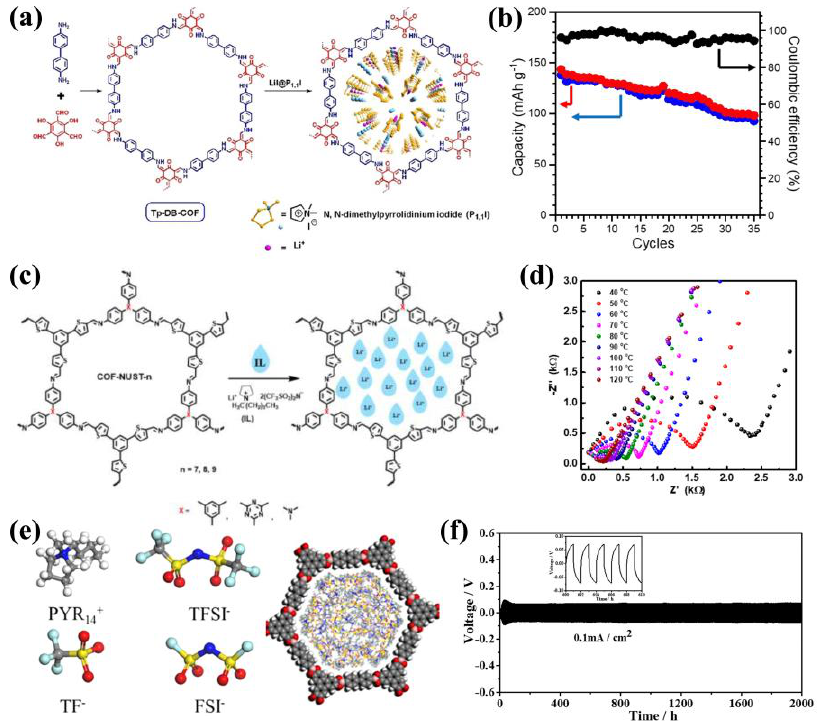
Figure 8. ( a ) Schematic view of LiI@P1,1I impregnated into COFs and chemical structures of P1,1I and Tp − DB − COF; ( b ) Cycling performances of LiFePO 4 |Li battery with LPC − 2 electrolyte at 0.2 C. Reproduced with permission from Ref. [53], Copyright (2021), John Wiley and Sons; ( c ) The structure of COF − IL composite electrolytes; (d) Nyquist plots of IL − 1.0@NUST − 7 at different temperatures. Reproduced with permission from Ref. [54], Copyright (2021), American Chemical Society; ( e ) Structure models of COFs@ILs; ( f ) The voltage – time curves of the Li|COF@IL|Li cell at the current density of 0.1 mA cm −2 . Reproduced with permission from Ref. [55], Copyright (2022), Elsevier.